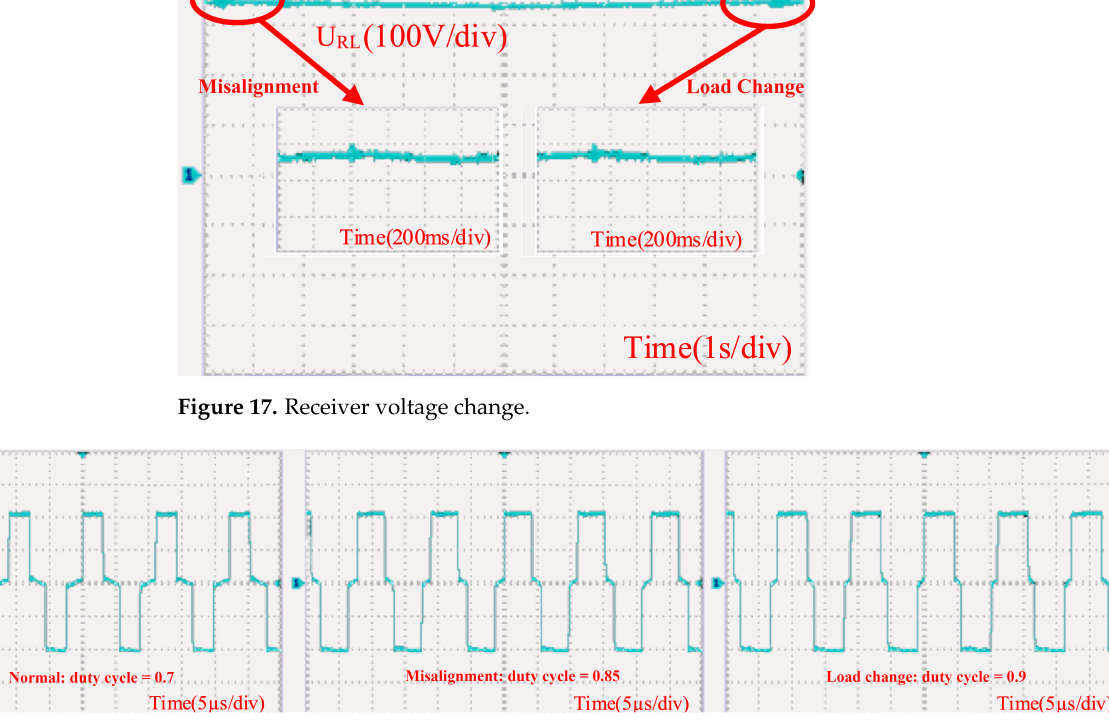
Figure 18. Transmitter-side inverter output voltage.